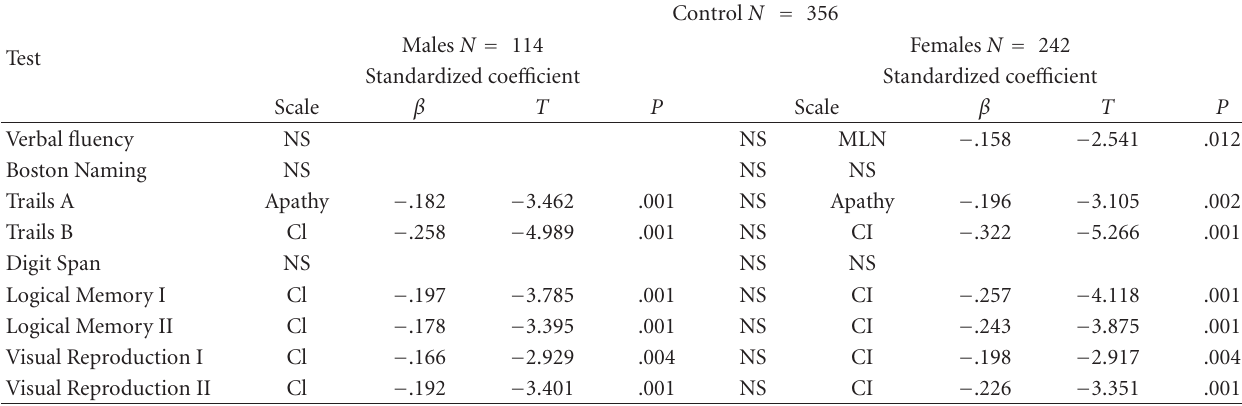
Table 2: GDS subscales and neuropsychological tests for control group by gender ∗ .